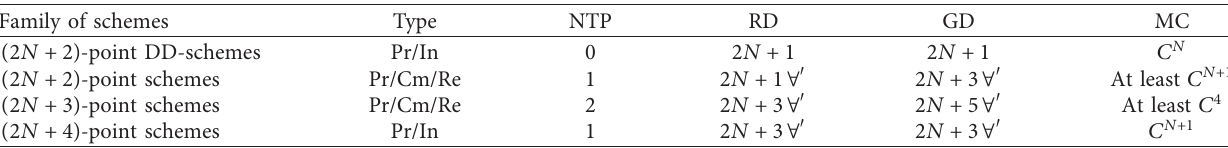
Table 8: NTP, RD, GD, MC, Pr, In, Cm, Re, and DD-schemes represent the number of tension parameter(s), degree of polynomial reproduction, degree of polynomial generation, maximum continuity, primal, interpolatory, combined, relaxed, and schemes of Deslauriers and Dubuc [1], respectively, where N ∈ N with N < 0